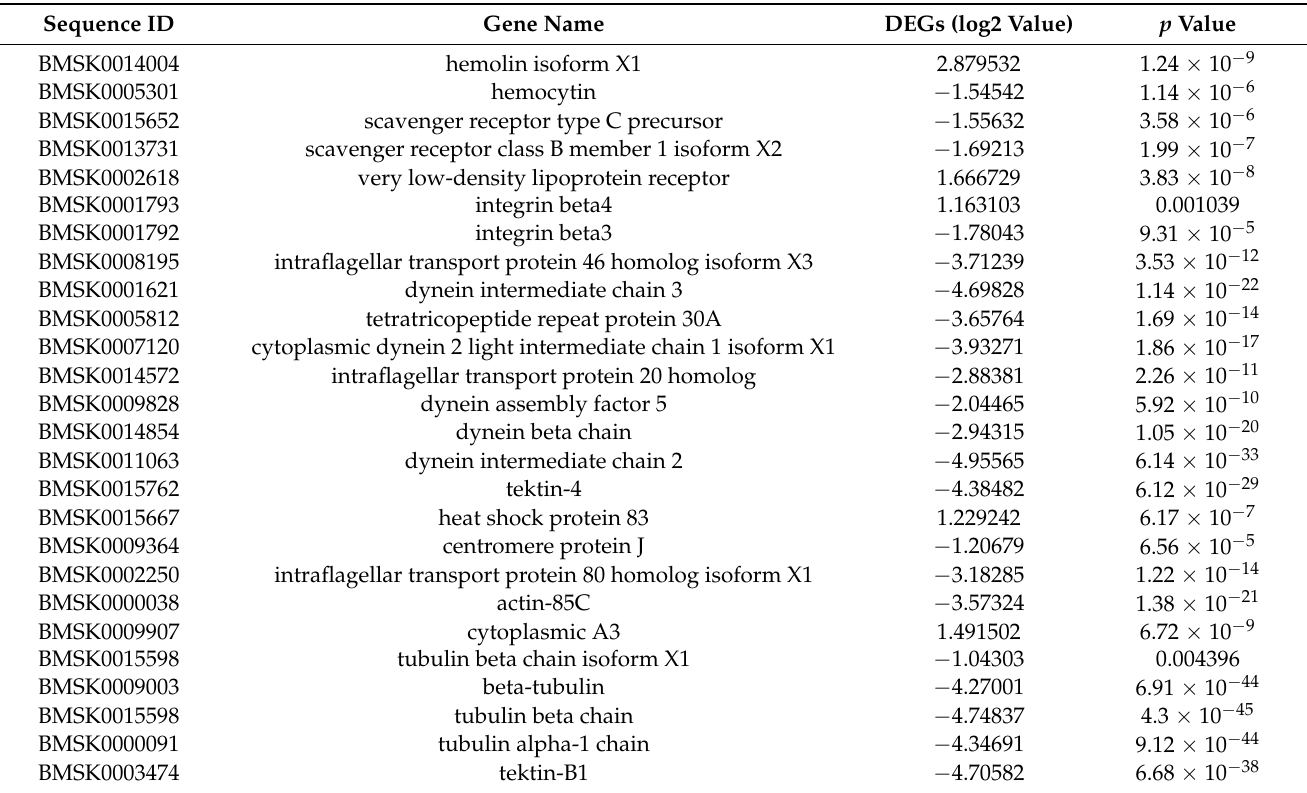
Table 4. Summary of DEGs involved in cellular immune response of the parasitized